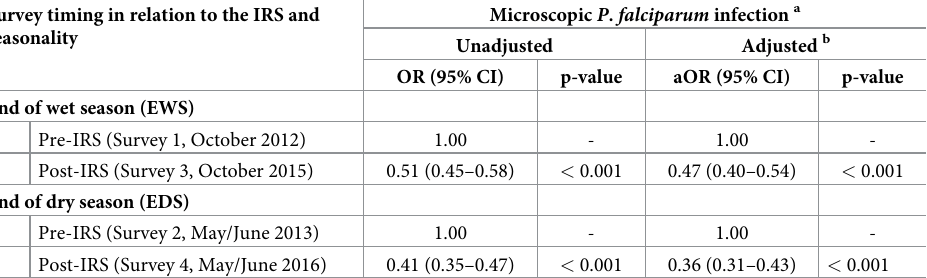
Table 1. Association between the IRS and microscopic P . falciparum infection prevalence at the end of the wet and dry seasons. Survey timing in relation to the IRS and seasonality